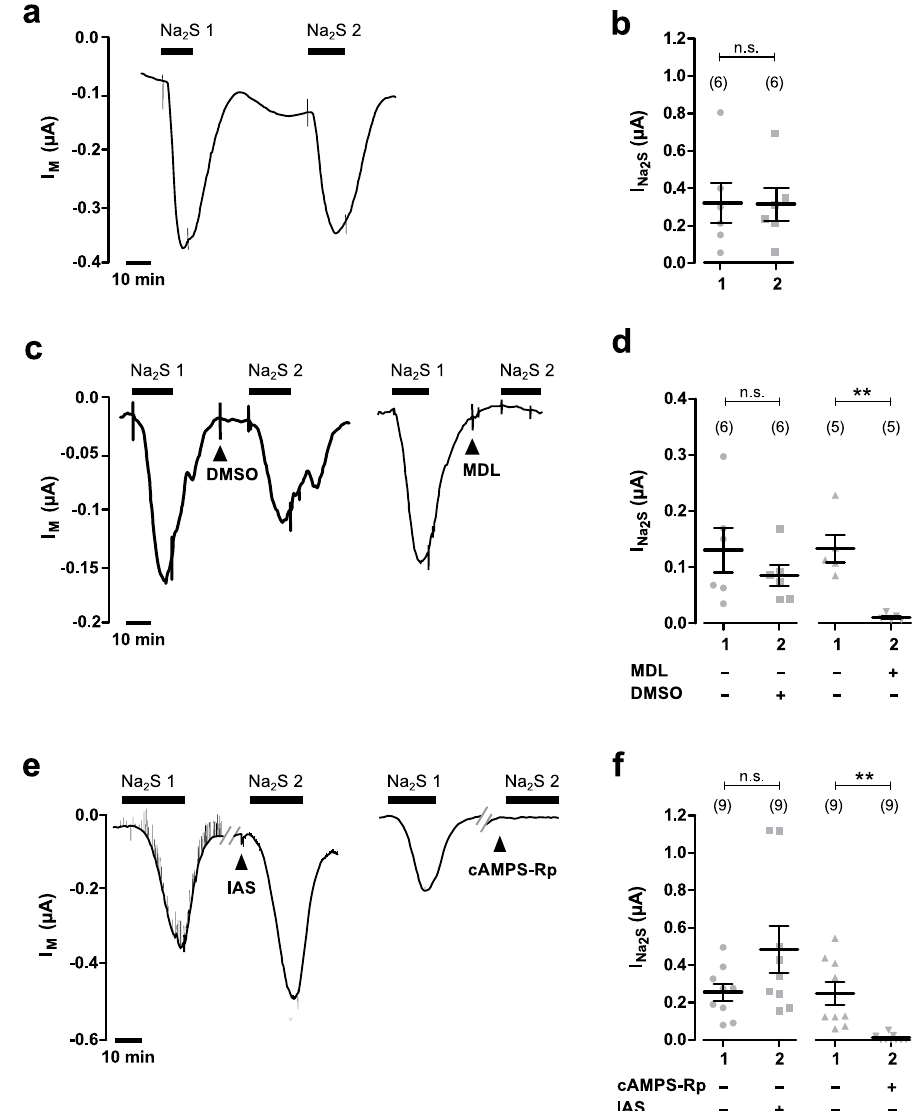
Figure 3. H 2 S stimulates CFTR via cAMP- and PKA-mediated signalling. ( a ) Representative current trace of a TEVC recordings of a CFTR-expressing oocyte. Transmembrane currents (I M ) were recorded and the oocyte was exposed twice to Na 2 S (50 µ M, black bar). ( b ) Statistical analysis of data obtained from experiments as shown in panel a. Depicted are values of the first (1) and second (2) Na 2 S-induced current (I Na2S ) from individual experiments (grey symbols) as well as means ± SEM (n.s. = not significant, Student’s paired t-test). I Na2S was calculated by subtracting the current before application of Na 2 S from the peak value after application of Na 2 S, resulting in positive values for I NA2S . ( c ) Representative current traces of TEVC recordings of CFTR- expressing oocytes. Transmembrane currents (I M ) were recorded and oocytes were exposed twice to Na 2 S (50 µ M, black bar) DMSO (0.1%; left trace) or the AC inhibitor MDL 12330 A (MDL, 20 µ M; right trace) were applied between the first and second stimulation with Na 2 S (black arrowheads). ( d) Statistical analysis of data obtained from experiments as shown in panel a. Depicted are values of the first (1) and second (2) Na 2 S-induced current (I Na2S ) from individual experiments (grey symbols) as well as means ± SEM ( ** P ≤ 0.01, Student’s paired t-test). I Na2S was calculated by subtracting the current before application of Na 2 S from the peak value after application of Na 2 S, resulting in positive values for I NA2S . ( e) Representative current traces of TEVC recordings of CFTR-expressing oocytes. Transmembrane currents (I M ) were recorded and oocytes were exposed twice to Na 2 S (50 µ M, black bar). The perfusion recording was stopped briefly between the first and second stimulation with Na 2 S (grey lines). Then, an intracellular-analogous solution (IAS) or IAS containing the PK-antagonist cAMPS-Rp (87 µ M) were injected into the oocytes before the second stimulation with Na 2 S (black arrowheads). ( f) Statistical analysis of data obtained from experiments as shown in panel a. Depicted are values of the first (1) and second (2) Na 2 S-induced current (I Na2S ) from individual experiments (grey symbols) as well as means ± SEM ( ** P ≤ 0.01, Wilcoxon signed rank test). Numbers of experiments (n) are indicated in